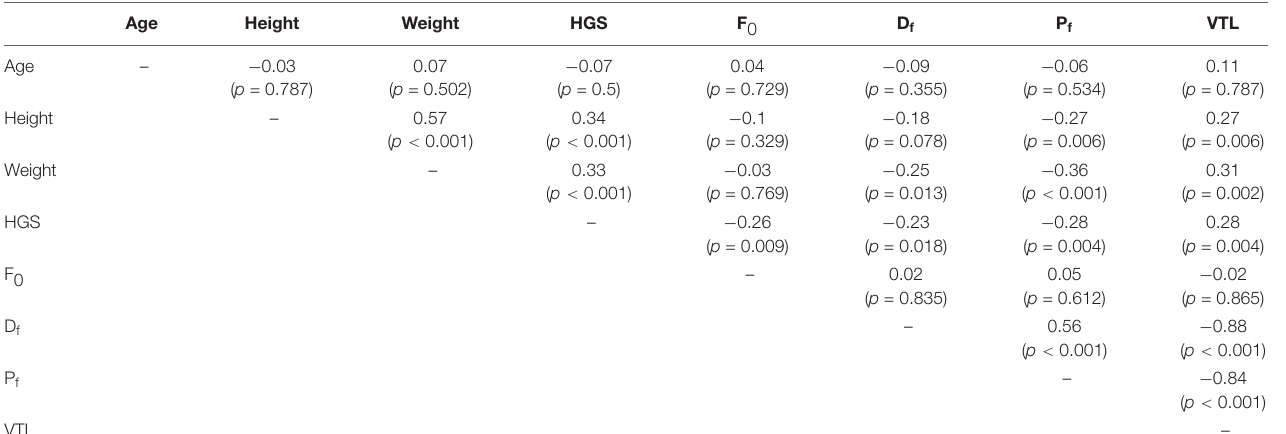
TABLE 3 | Zero order Spearman correlations of anthropometric correlates of physical formidability and acoustic